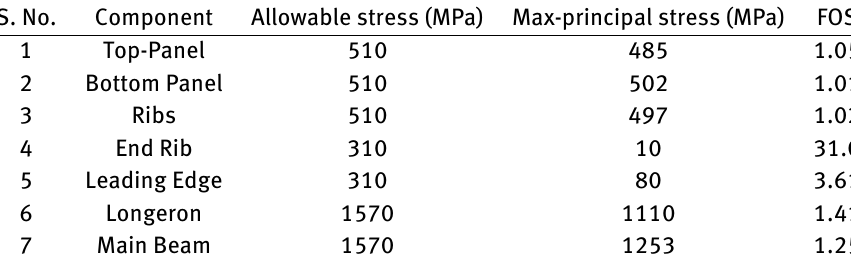
Table 5: Factor of Safety in Metallic parts S. No.